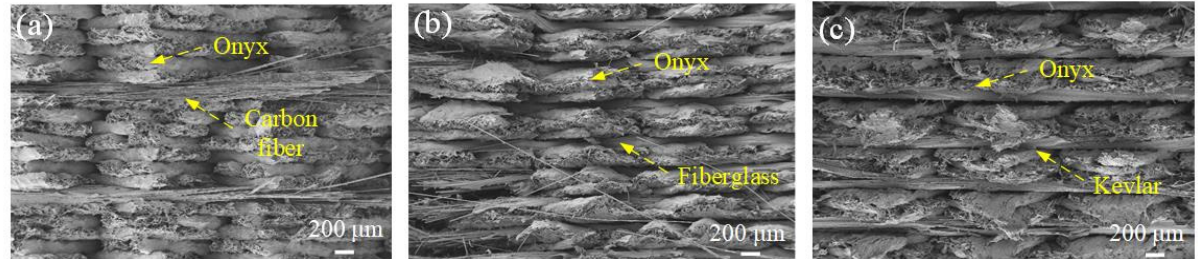
Figure 4. SEM micrographs of shearing fractured surfaces of composites containing fibers arranging at 90°: ( a ) carbon fibers filled, ( b ) glass fibers filled, ( c ) Kevlar fibers filled.